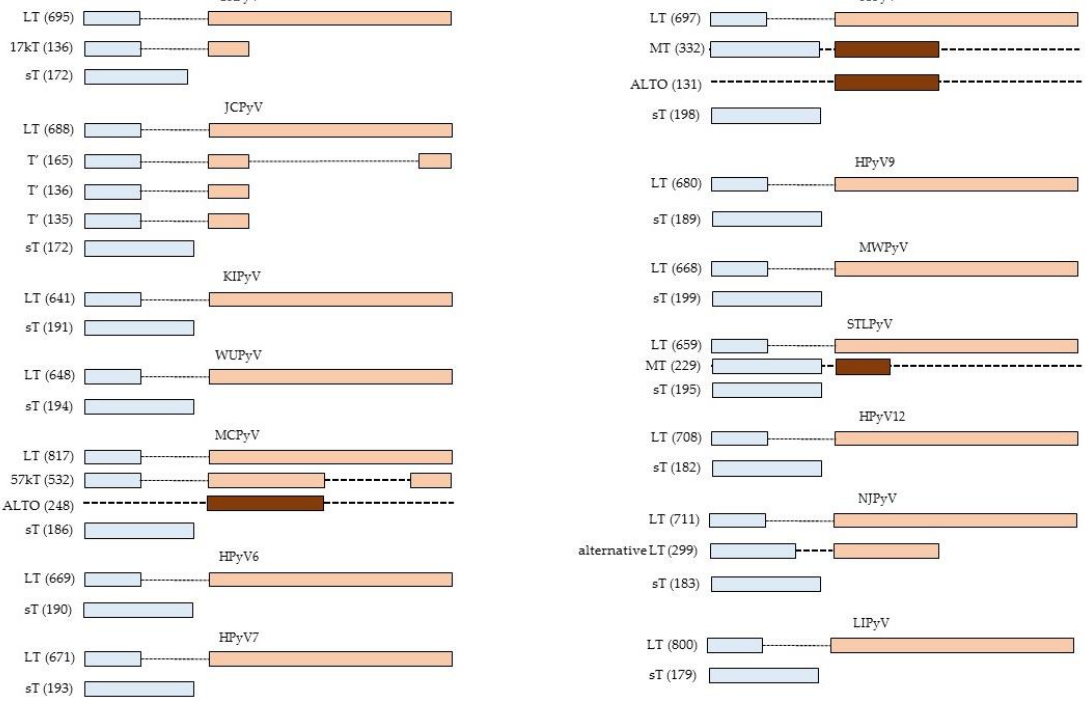
Figure 1. Proven and putative early proteins are encoded by the different HPyV. The number in parenthesis is the number of amino acid residues in the protein. The dashed lines represent non-coding regions, while the colored boxes depict the distinct areas that compose the protein. Part of the N-terminal region of LT and sT has the same amino acid sequence and, therefore, the same color was used. The proteins are not drawn to exact scale. LT = large T-antigen. sT = small T-antigen. MT = middle T-antigen. ALTO = alternative LT open reading frame.